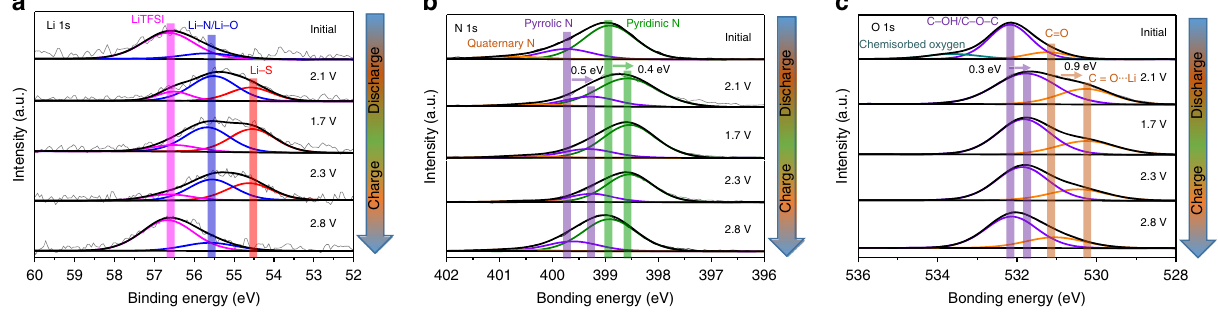
Fig. 6 XPS spectra of the sulfur cathode with 0.5 wt% N-CDs electrolyte at different charge/discharge states. a Li 1s, b N 1s and c O